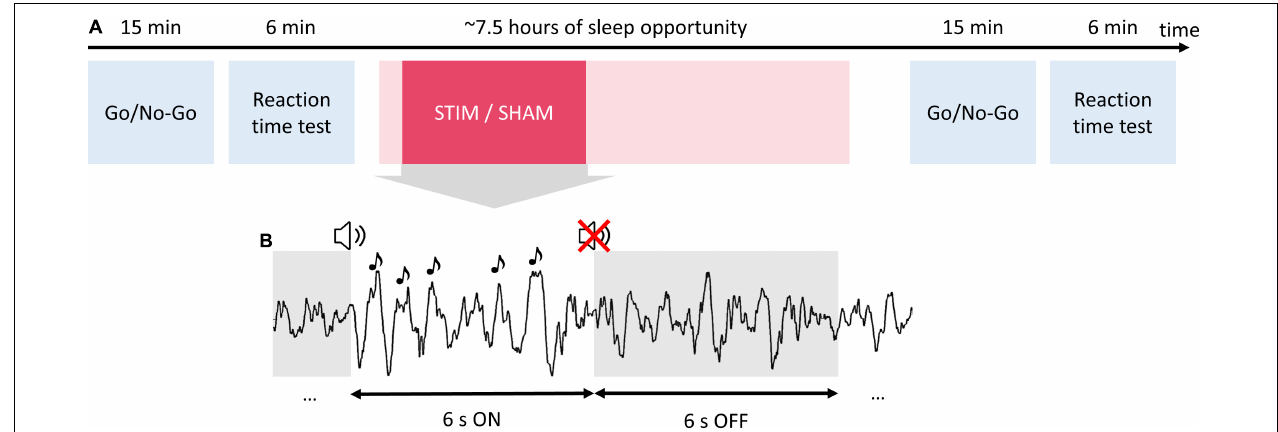
FIGURE 1 | Study procedures and auditory stimulation protocol. Participants completed two experimental sessions in the sleep laboratory separated by 1 week. (A) During each experimental session, participants performed a Go/No-Go task and reaction time test in the evening before going to bed. Then participants were given a 7.5-h sleep opportunity. In one of the two experimental sessions, the phase-targeted auditory stimulation (stim) was applied for 2.5 h after the first stimulus onset. In the other session, no sounds were presented (sham). The next morning, at least 30 min after awakening, participants performed again the Go/No-Go task and reaction time test. (B) During the stimulation, pink noise pulses (1/f, 50 ms) were delivered in 6-s blocks (ON windows) followed by a 6-s pause (OFF windows).